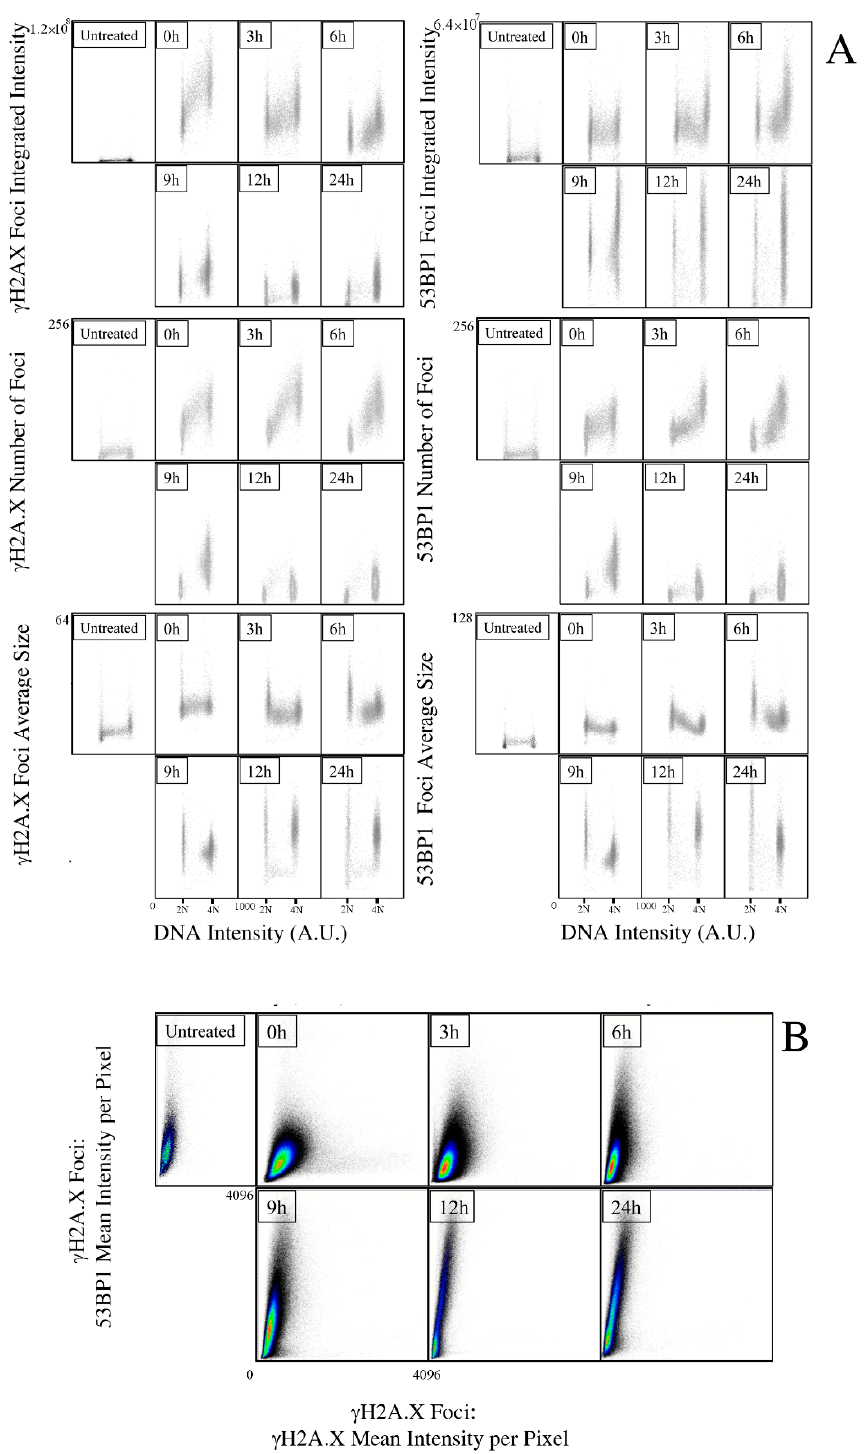
Figure 2. Image cytometry analysis of the IR-induced foci kinetics after X-ray irradiation. ( A ) After cell identification, γ H2A.X (left) and 53BP1 (right) signals were segmented in each detected nucleus to locate and count foci, and measure their integrated intensity per nucleus (i.e., sum of the intensity of all the foci present in a nucleus) and their average size. ( B ) Statistical analysis of the foci intensity distribution. The entire population of the indicated foci ( n > 10 5 ) was analyzed as an independent entity without considering the cell of origin. The relative distribution of the two parameters reveals the kinetics of recruitment of 53BP1 protein into γ H2A.X foci. Reported data refer to a representative experiment.